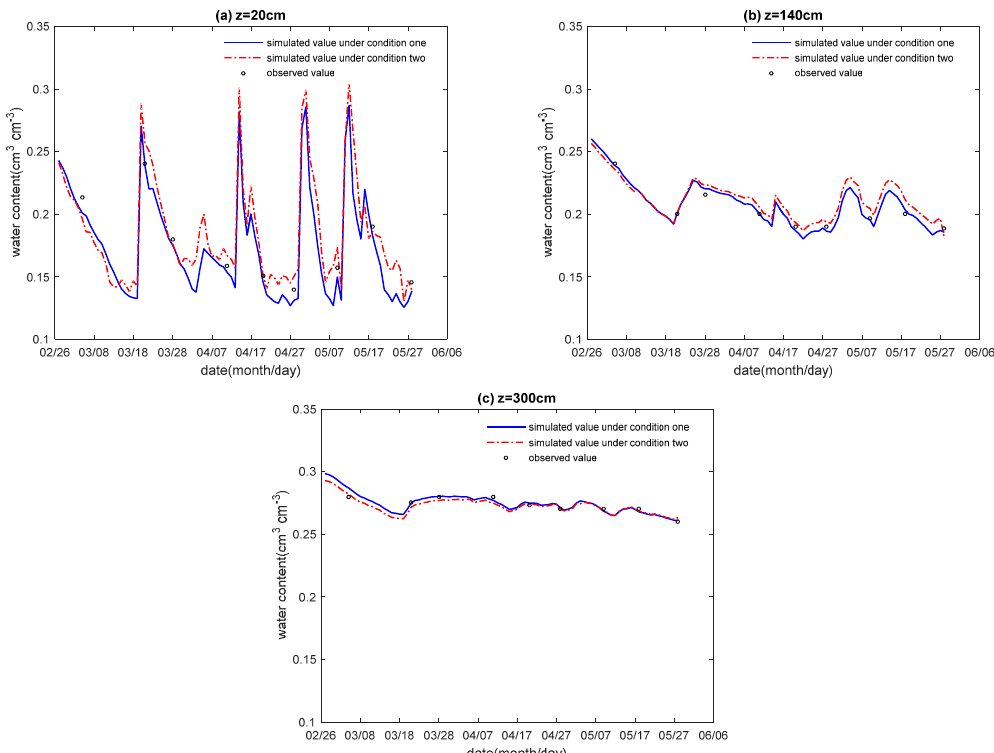
Figure 6. Comparison between simulated and observed values for soil water content with time at different soil depths under conditions one and two.